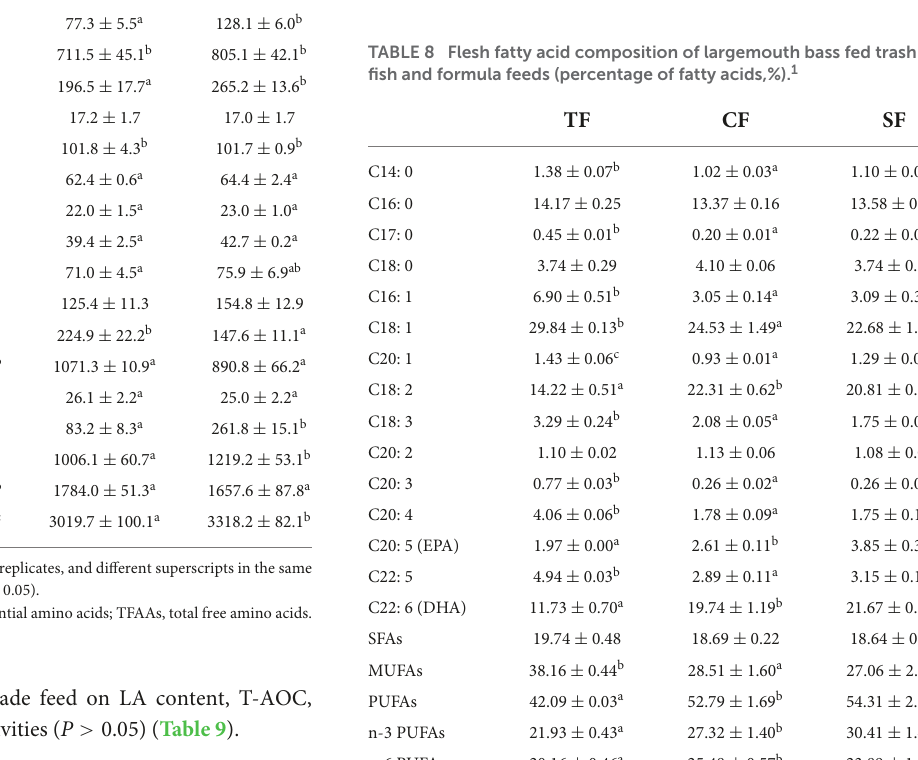
TABLE 7 Flesh free amino acid composition of largemouth bass fed trash fish and formula feeds (wet weight, mg/kg). 1 TF CF SF Aspartic acid*